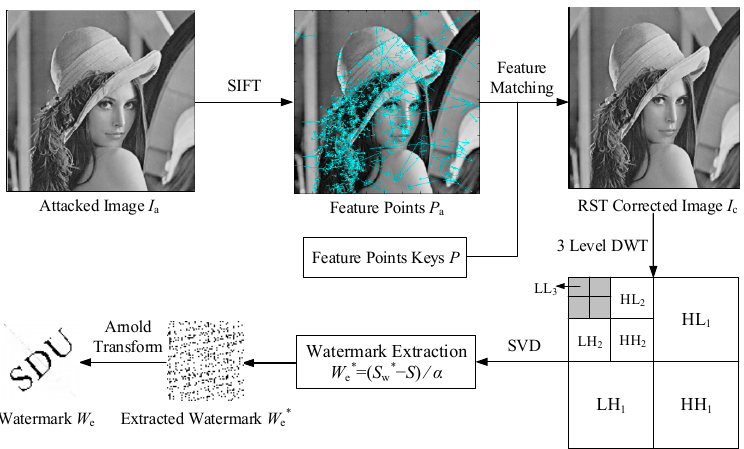
Figure 3. Flow diagram of the watermark extraction process.